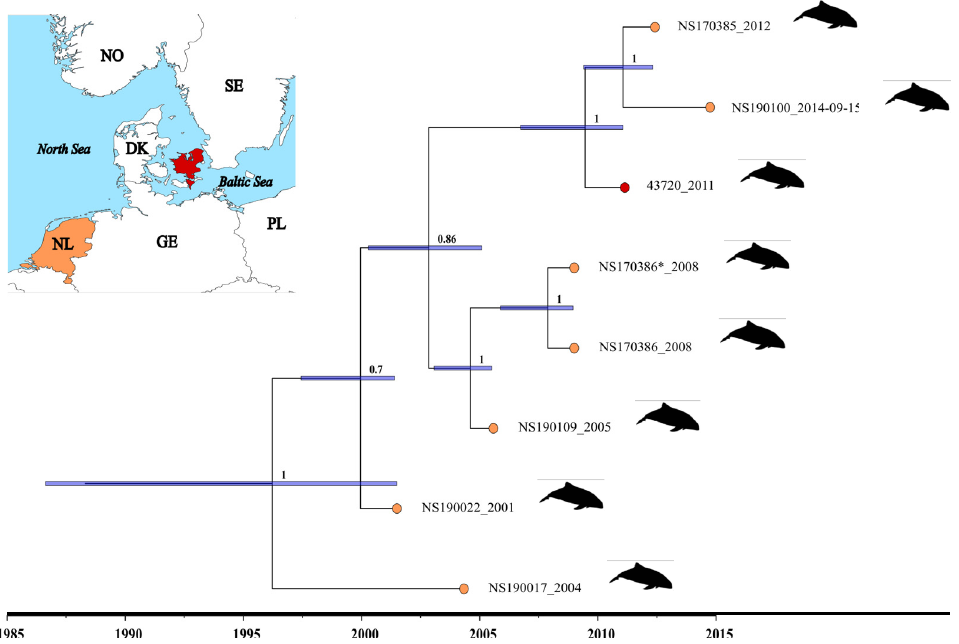
Figure 2. Time-calibrated Bayesian phylogenetic tree of the Baltic PhoPeV sequence (43,720) described here and seven recently published PhoPeV sequences from the Netherlands collected between 2001 and 2014 (GenBank accession number: MK910230-37). The tree was generated in BEAST 2.5.2 based on the concatenated nucleotide alignment comprising the 5 ′ untranslated regions (UTR) and the regions coding for C, E rns , E1 and E2 proteins. The tree was generated using a relaxed exponential clock and a coalescence constant tree prior (Supplementary Table S1). The colour-coded circles at the tips indicate the countries (the red colour represents Denmark, and the orange colour represents the Netherlands) where the animals were collected. The node bars represent the highest posterior density (HPD) interval of the time estimates, while the tree support is shown as posterior values at each